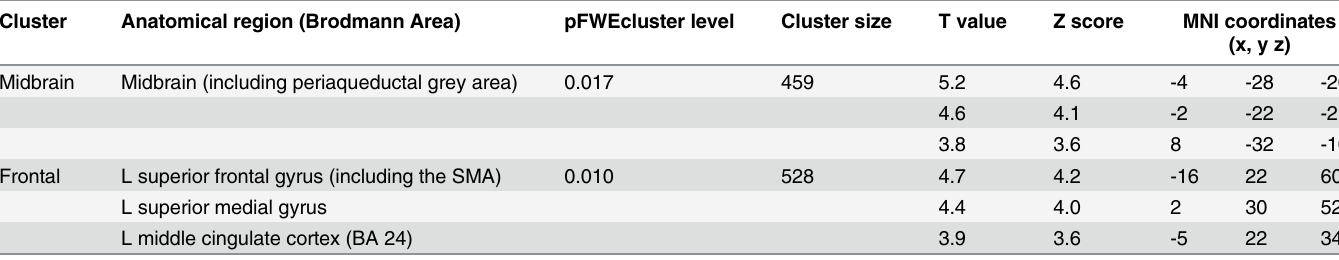
Table 2. Whole-brain analysis: Group effect (CD > controls) in the Emotion Model.